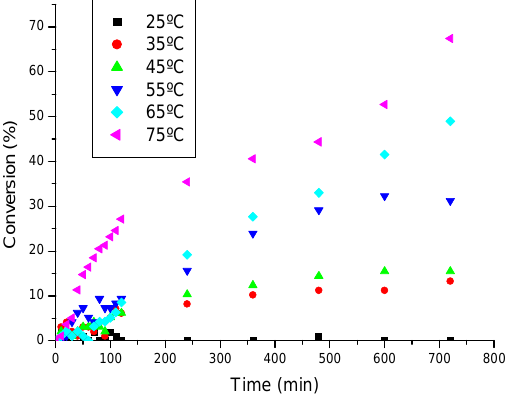
Figure 6 . Effect of the temperature on the ethanolysis of oleic acid catalyzed by SnCl